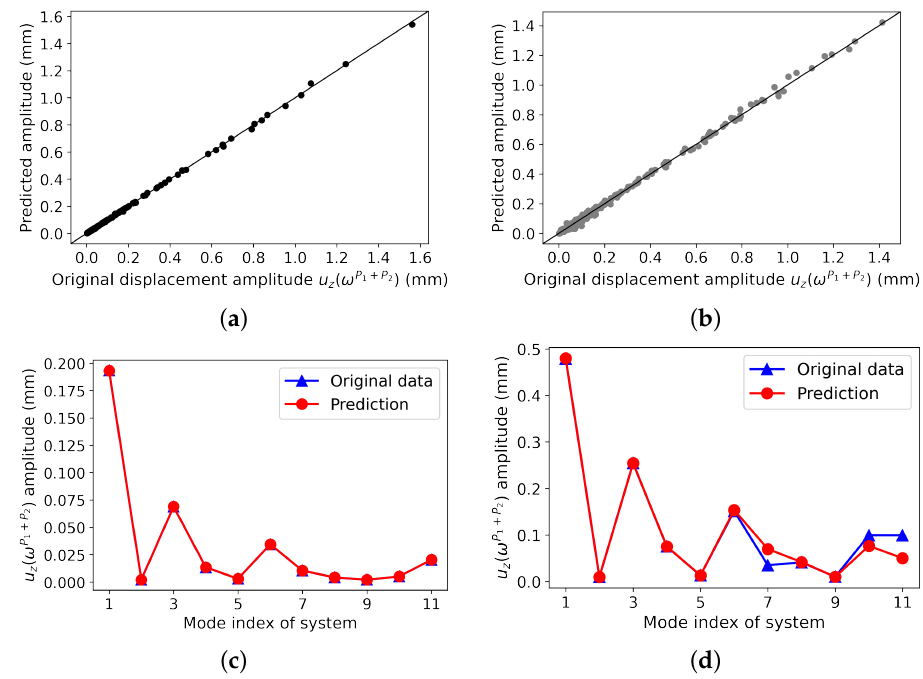
Figure 11. Results of surrogate model H 2 . ( a ) Comparison of predicted and original values for training set. ( b ) Comparison of predicted and original values for testing set. ( c ) Comparison for sample µ P 1 = µ P 2 = 2.2 mm in DOE with minimum (cid:101) = 0.031%. ( d ) Comparison for sample µ P 1 = 1 mm, µ P 2 = 1.6 mm in DOE with maximum (cid:101) =